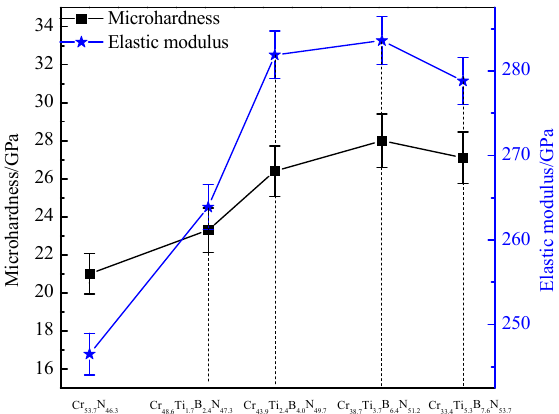
Figure 4. Hardness and elastic modulus of Cr ‐ Ti ‐ B ‐ N films.